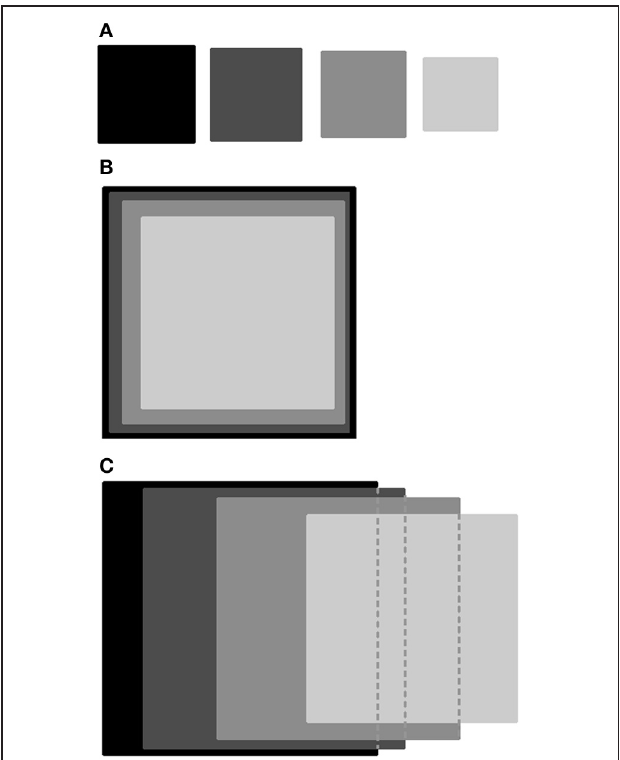
FIGURE 3 | Task progression as set inclusions. Tasks DD, DB, KA, and FB are represented as squares in decreasing gray level. Square area represents amount of kids successfully completing each task, and area overlap among successive tasks quantifies the amount of kids that responded correctly for both tasks. (A) Illustrative lack of scaling. (B) Illustrative perfect scaling. (C) Actual experimental results.